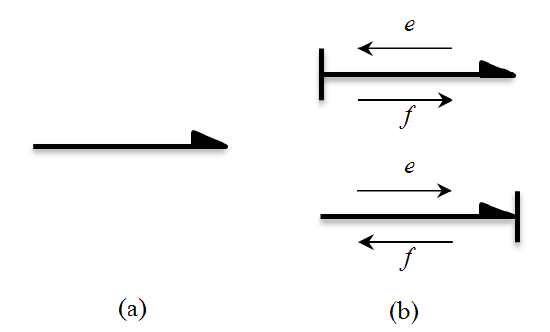
Figure 1: (a) Sign convention on the power bond. (b) Notation convention for effort and flow re-